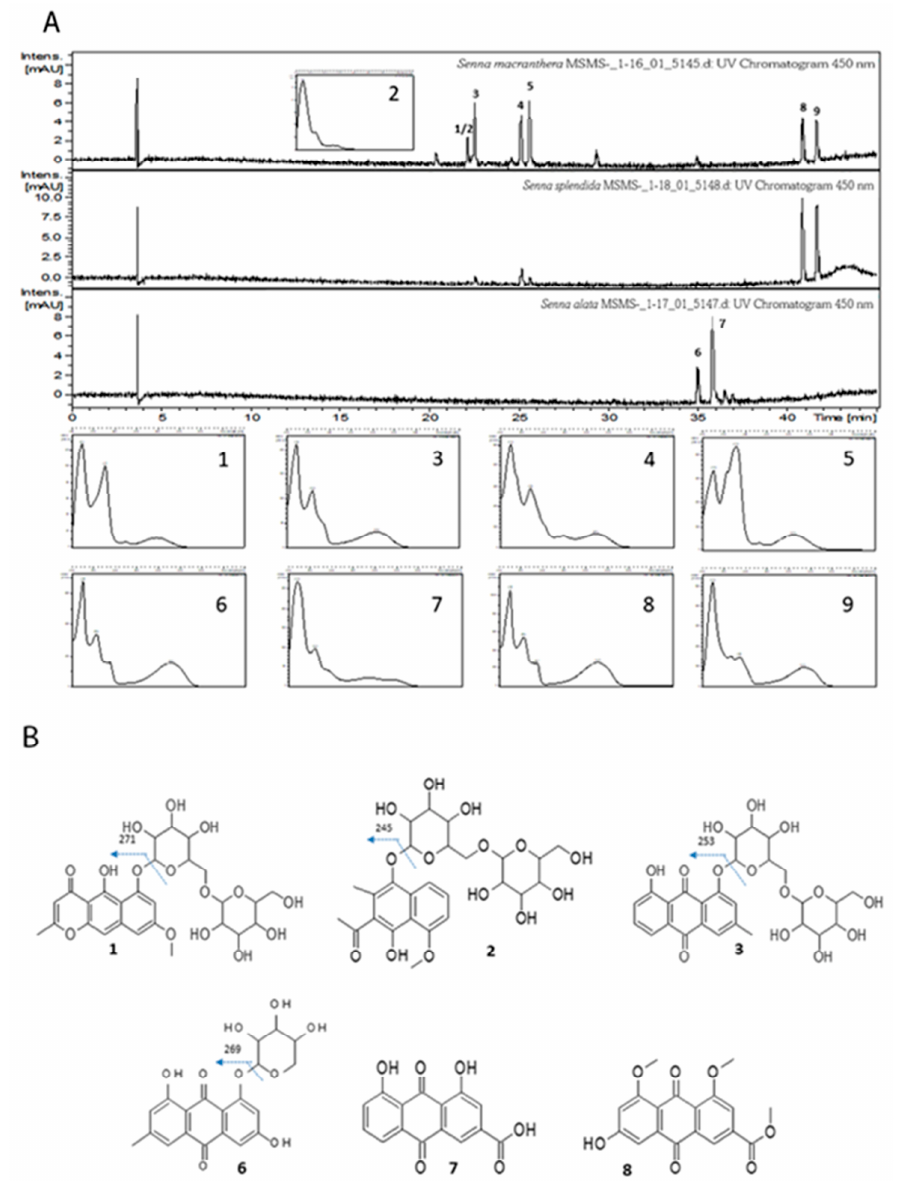
Figure 1. ( A ) Chromatograms of Senna extracts registered at 450 nm and UV/Vis spectra of photoactive compounds; ( B ) Molecular structure of some photoactive compounds. Table 2. High-resolution MS data from the photoactive compounds.